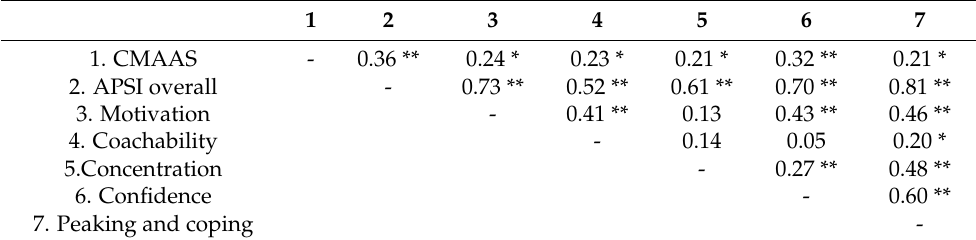
Table 2. Pearson correlation coefficients for CMAAS and